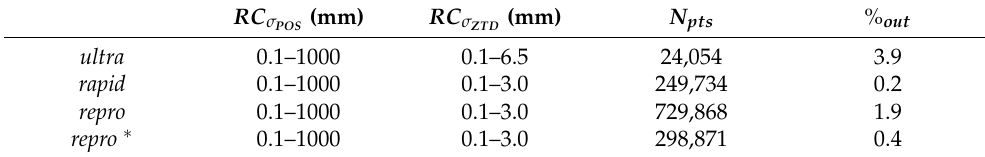
Table 2. Screening used for the GNSS estimates: threshold for range check on 3D position formal errors and ZTD formal errors; number of data points after screening and screening rejection rate. ∗ corresponds to values that are computed after the change of the location of the antenna.